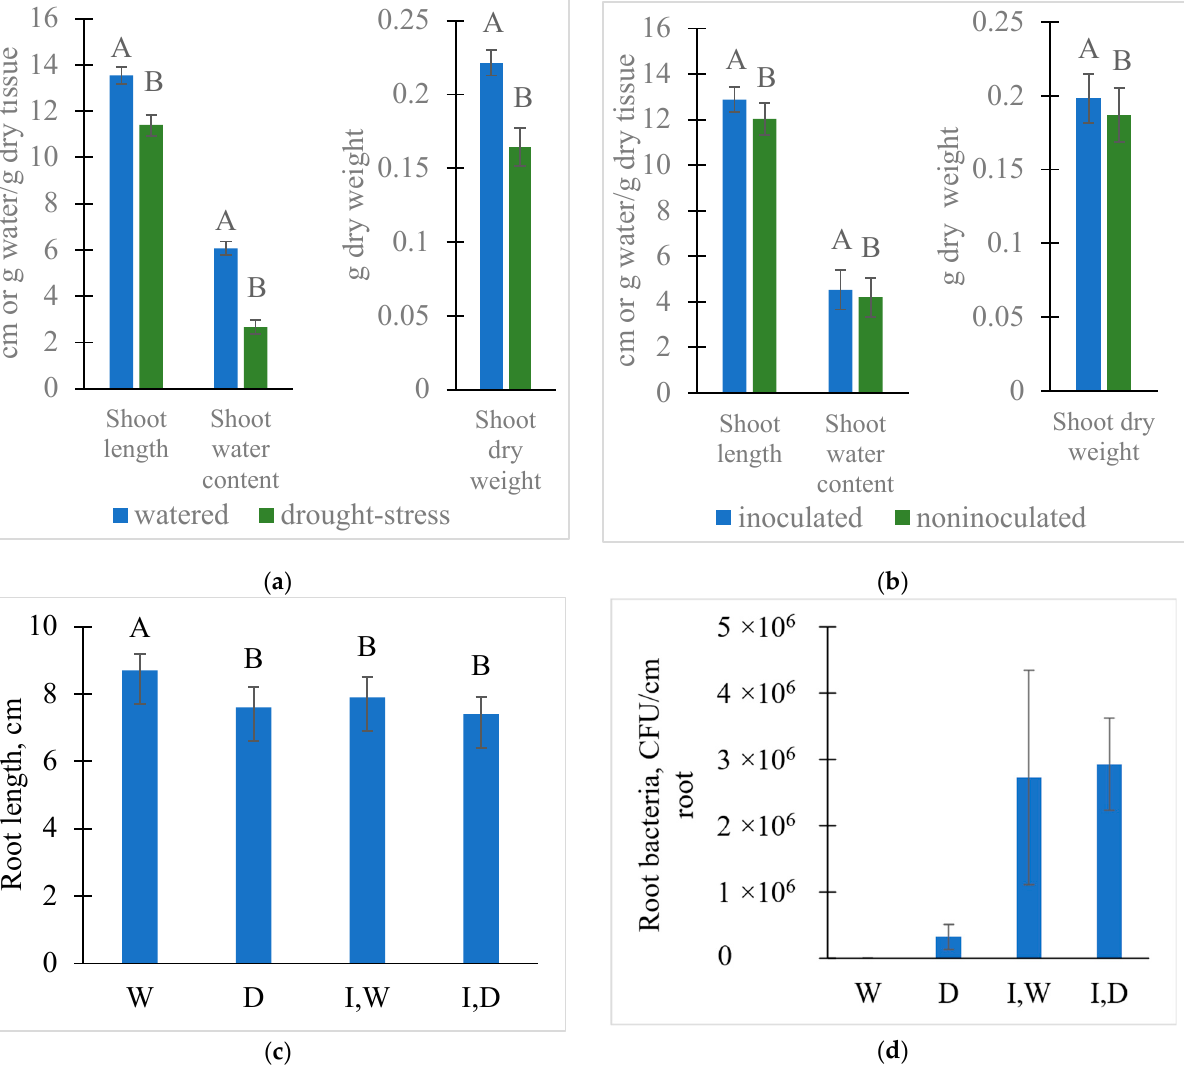
Figure 1. Effects of growth conditions on plant development and root colonization by drought and root colonization by Pc O6. Plant were grown with four treatments: W watered, D drought-stressed, I,W inoculated and watered and I,D inoculated and drought stressed. ( a ) Changes in shoot length, shoot dry weight, and water content for watered and drought-stressed plants. ( b ) Changes in shoot length, shoot dry weight, and water content for plants grown without and with inoculation by Pc O6. ( c ) Changes in root length induced by drought and inoculation with Pc O6. ( d ) The colony forming units (CFU) recovered from the roots of watered and drought-stressed wheat seedlings when grown with or without Pc O6 inoculum. Data in ( d ) are shown as CFU/cm of the root. A bar represents the mean from nine independent boxes per treatment, and the 95% confidence intervals are shown. Differing letters show statistically different treatments by Tukey Honestly significant difference test ( p = 0.05).